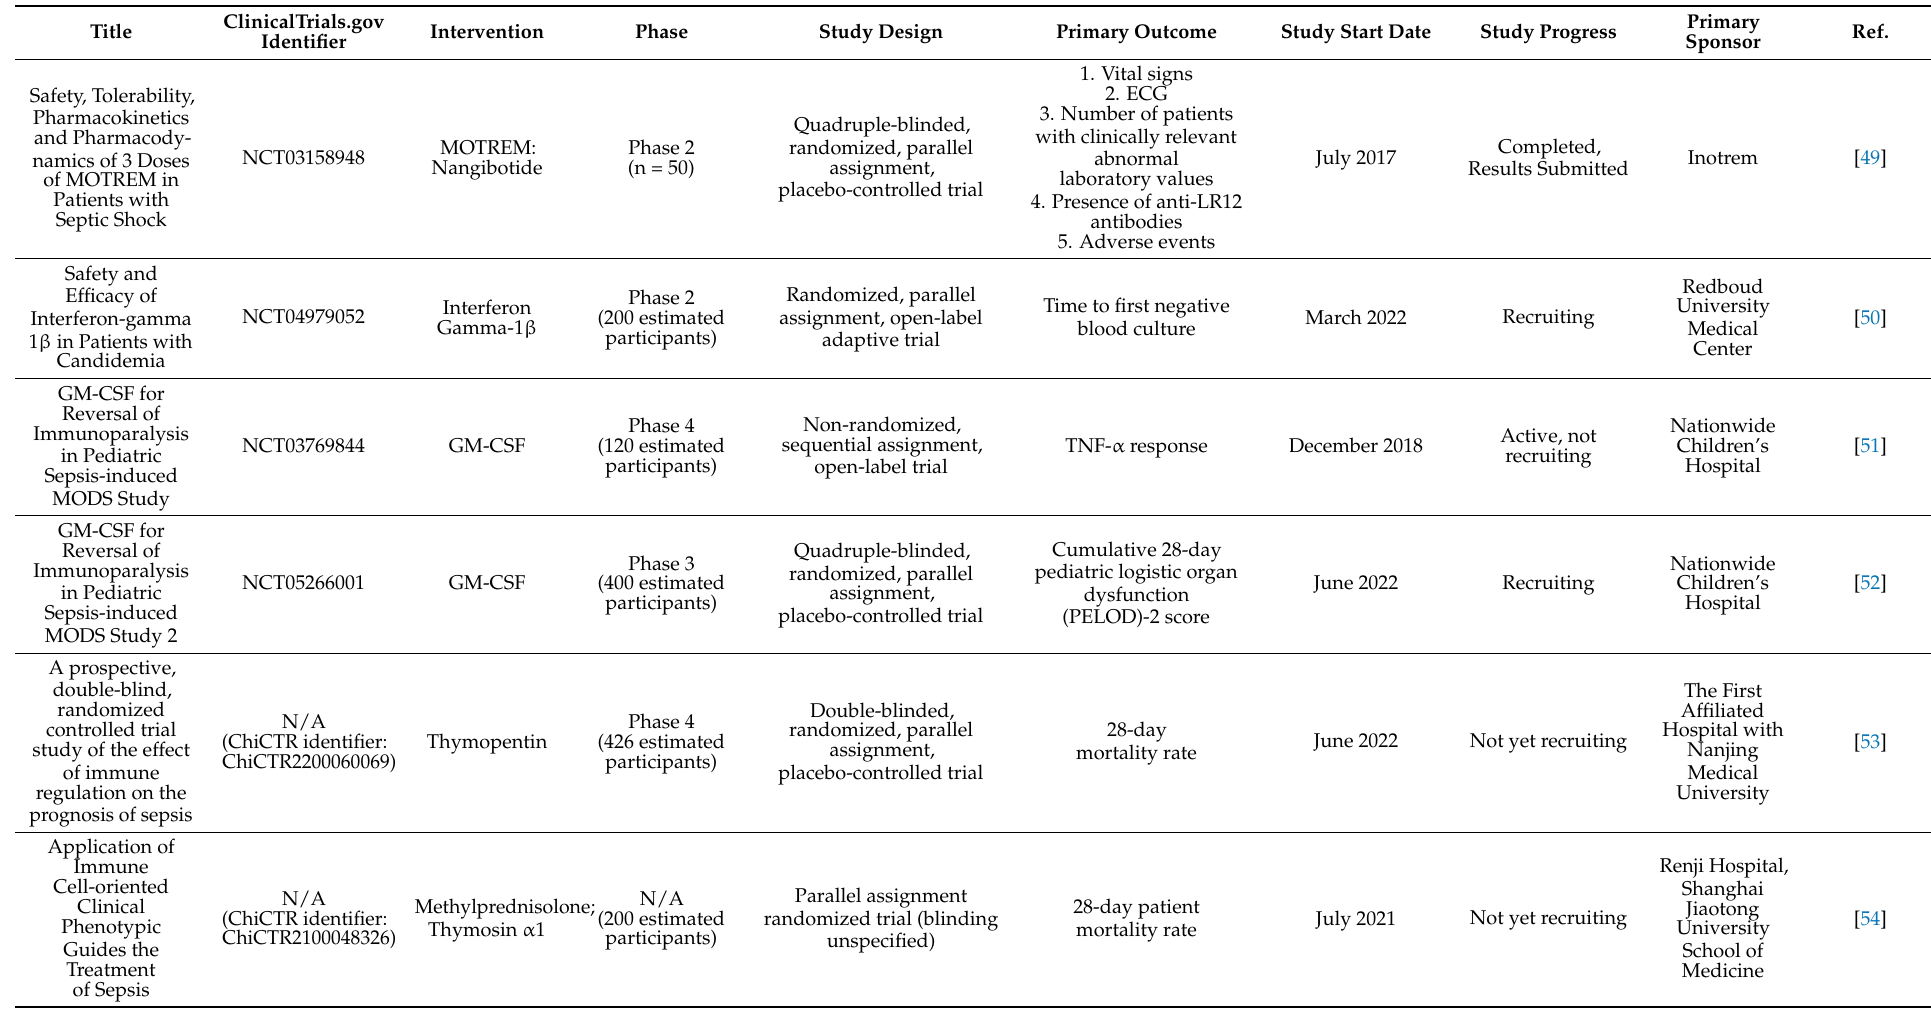
Table 2. Ongoing interventional studies for the treatment of sepsis and septic shock from the last 10